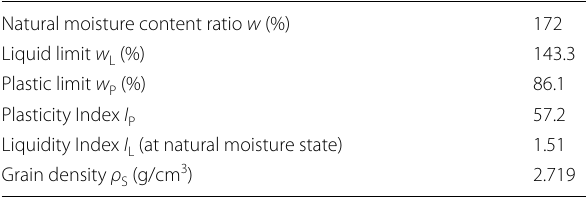
Table 1 Mechanical properties of the analyzed soil sample (Kameda et al.,